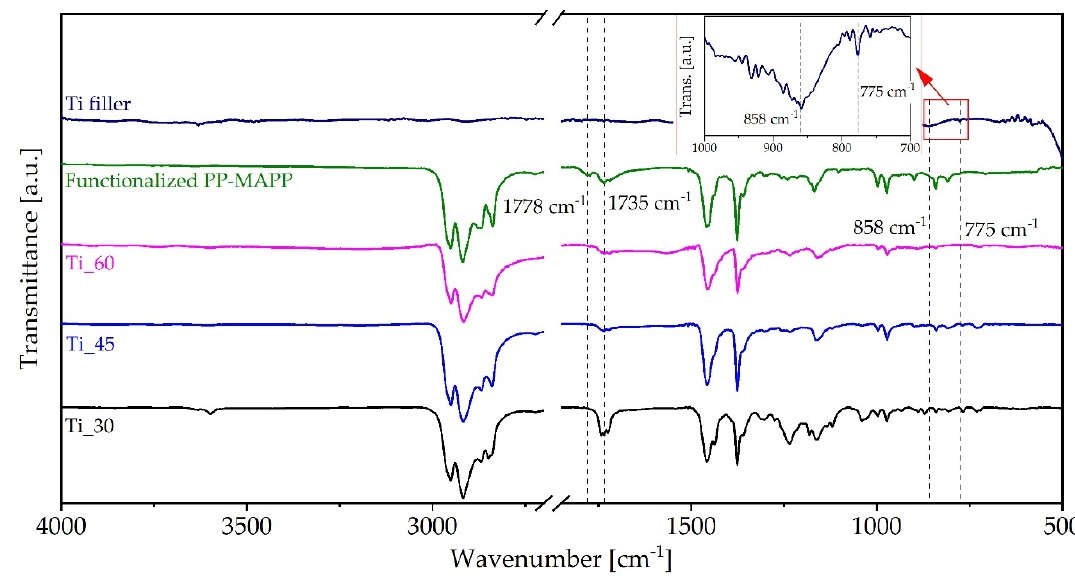
Figure 12. ATR-FTIR spectra of Ti materials, reference binder system, and Ti filler material.